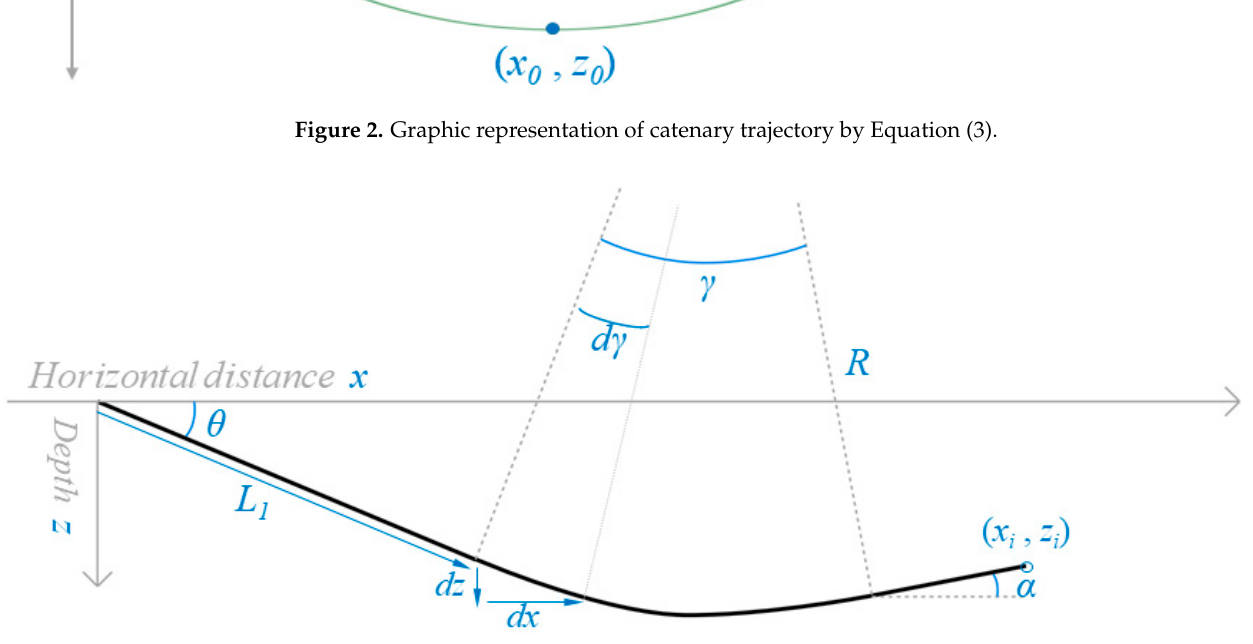
Figure 3. The geometric profile of alternating straight and curvilinear segments. (cid:3420) dx = R × ( sin γ – sin ( γ – d γ )) dz = R × ( cos γ – cos ( γ – d γ )) According to Equations (4)–(6) above, the designed alternating straight and curvilin- ear segments can be detailed with tiny segments with coordinates. The whole geometry can be constrained only by four kinds of geometric parameters within the assigned do- main, including the inclined angle of the straight segment θ (clockwise is positive and counterclockwise is negative), the length of segment L i , the angle of curved segment γ , and the curved segment radius R . If the central segment of the trajectory is considered to